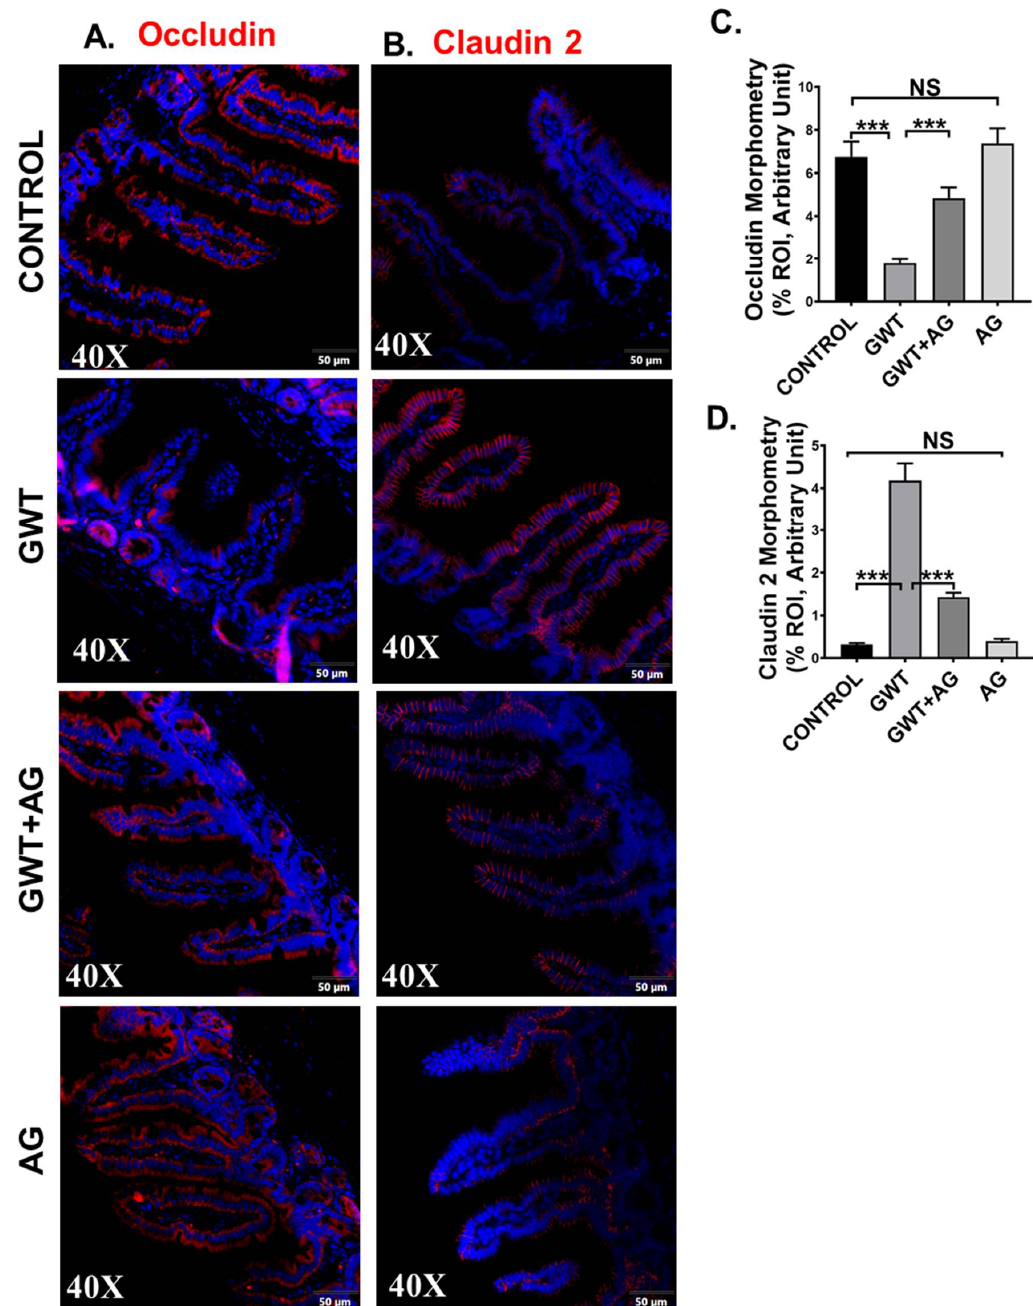
Figure 3. GW chemical exposure causes gut leakiness due to altered expression of intestinal tight junction proteins, improved by AG treatment. Formalin-fixed, paraffin-embedded 5 µ m intestinal slices from CONTROL (mice treated with vehicle only), GWT (GW chemical exposed mice), GWT+AG (mice co-exposed to both GW chemicals and AG), and AG (mice treated with AG only) groups were used for immunofluorescence imaging. Representative immunofluorescence images depicting ( A ) Occludin and ( B ) Claudin-2 reactivity (red) in the small intestine, counterstained with DAPI (blue) of CONTROL, GWT, GWT+AG, and AG mice groups. Images were taken at 40× magnification. Morphometric analysis (calculated as %ROI) of ( C ) Occludin and ( D ) Claudin-2 immunoreactivity. Y -axis represents % positive immunoreactive area (% ROI) ( n = 3; mean value taken from three separate microscopic fields) (*** p < 0.001, NS: non-significant). Data were represented as mean ± SEM and statistical significance was tested using unpaired t -test between the groups (* p < 0.05, ** p < 0.01, *** p < 0.001), followed by Bonferroni Dunn Post hoc corrections.